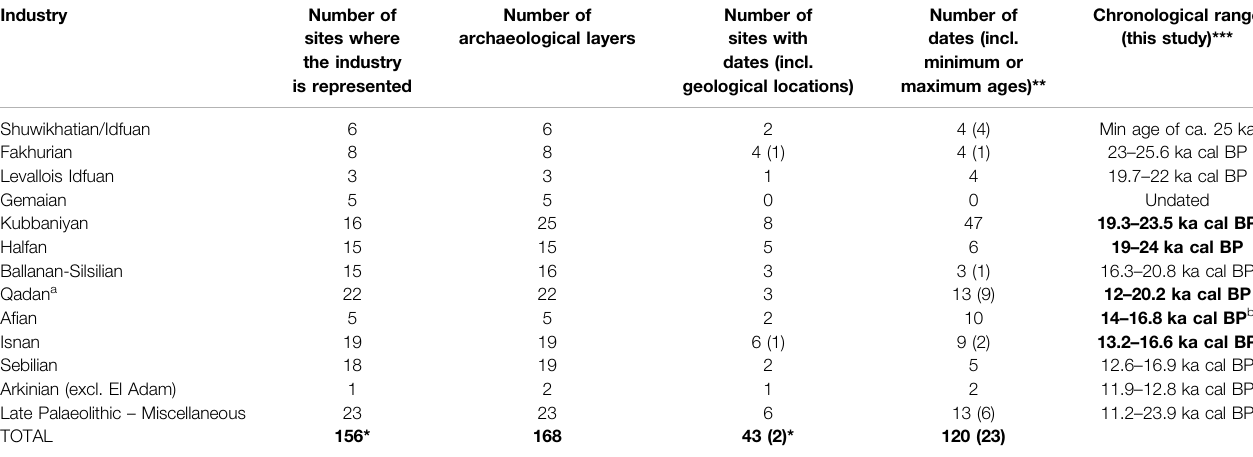
*Thesetotalsdifferfromthetotalnumberofarchaeologicalsites.Thetotalof156correspondto151archaeologicalsitesincluding fi vesiteswheretwoindustriesarerepresented.43dated locations correspond to 41 dated sites plus two geological localities. ** the number of dates does not include dates that were rejected by the authors or for which the association with archaeologicalmaterial was not sustained on stratigraphicgrounds. *** Onlyradiocarbon dateswith error margins < 1,000 and which did not represent minimum or maximum ages were taken into account. In bold are chronological ranges based on more than fi ve dates. a Sites 34C, 605 and 621 were removed from the count of Qadan sites since these present clear signs of admixture (see review in Usai, 2008; Usai, 2020). It is probable that other sites attributed to the Qadan also represent mixed contexts (Usai, 2020). b AlthoughdoubtswerecastontheassociationofthesiteofMakhadma4totheA fi an(Leplongeon,2017),intheabsenceofdetailedcomparativeanalysisthatwouldcon fi